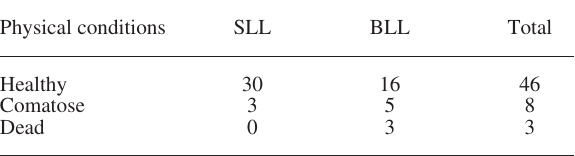
Table 2. – Physical condition of turtles captured by Sll and Bll.